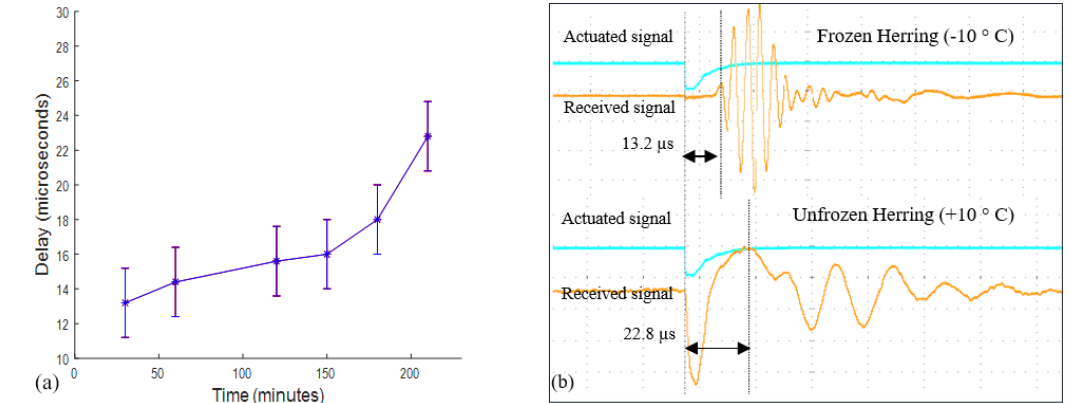
Figure 5. Change in signal delay concerning time while a 3cm-thick herring fish was unfrozen from − 10 to + 10 ◦ C and (b) oscilloscope measurement of the delay